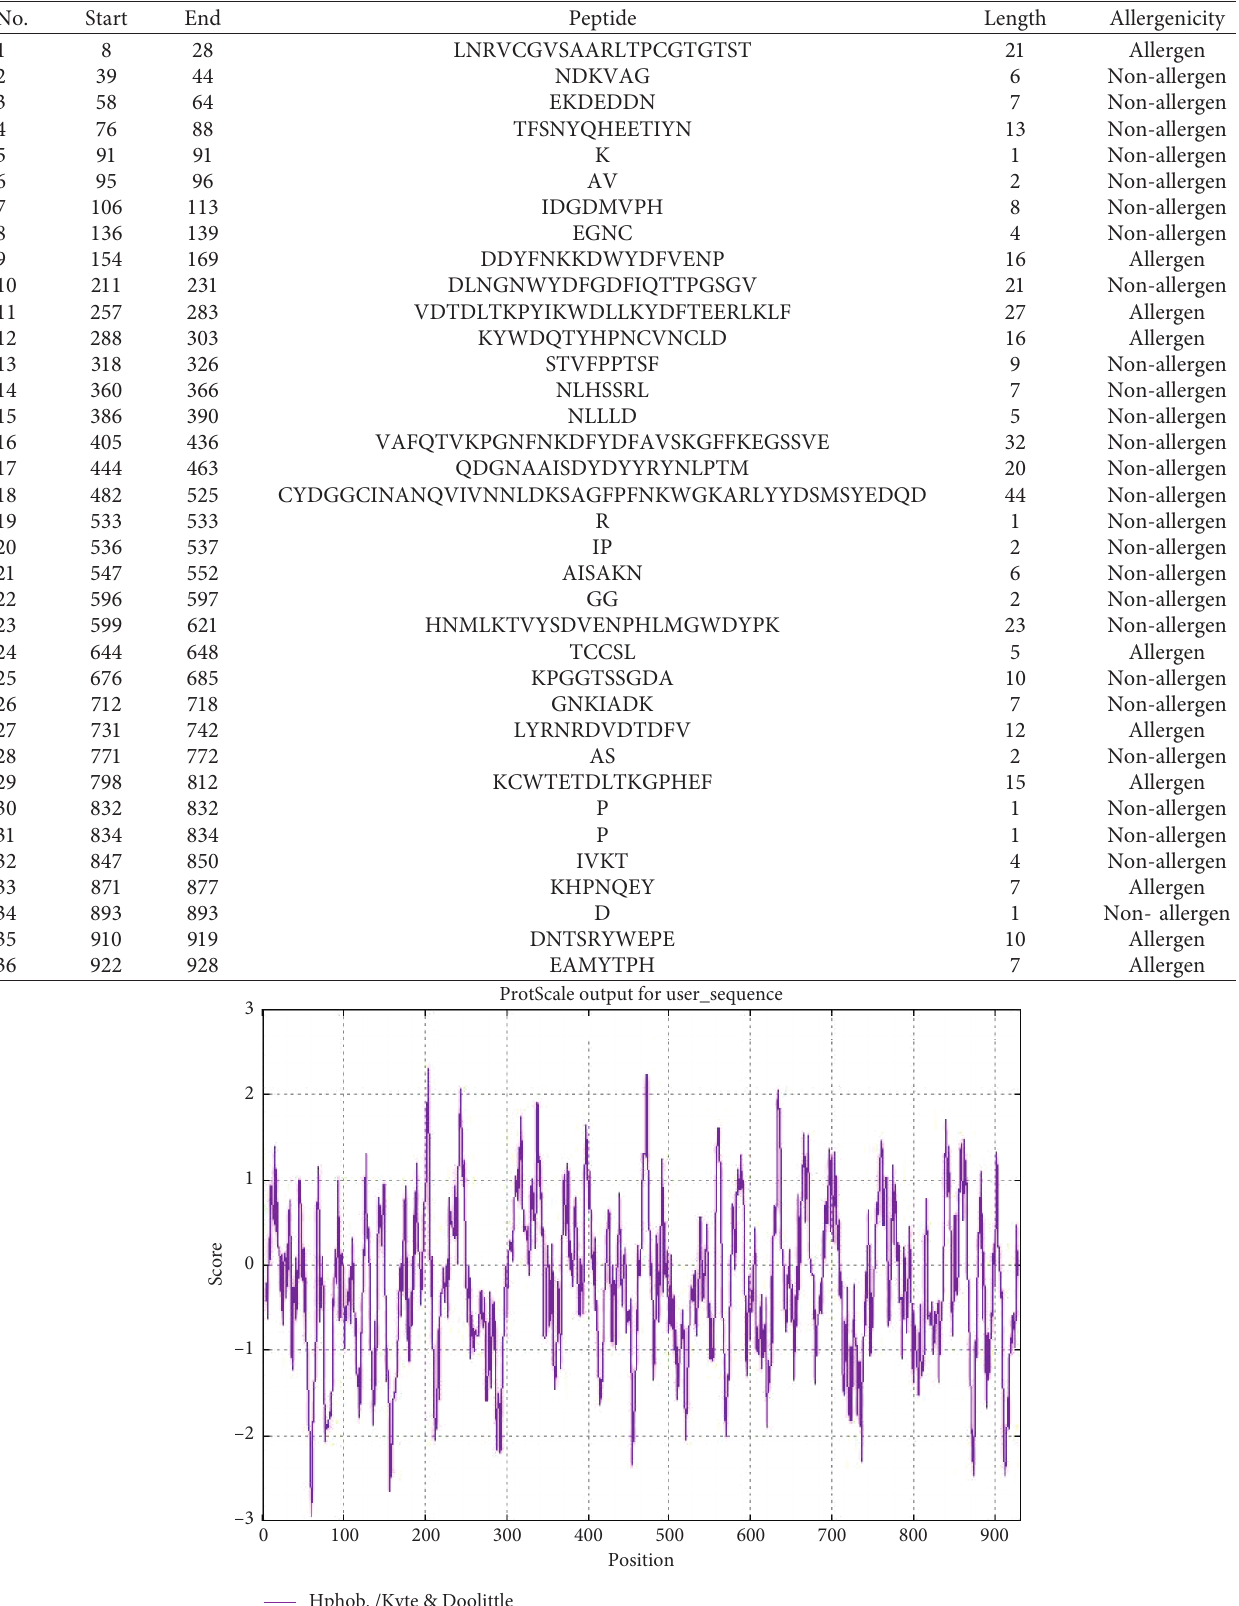
Table 2: B-cell epitope prediction of RdRp protein sequence of SARS-CoV-2 Indian isolate and its allergenicity. No.